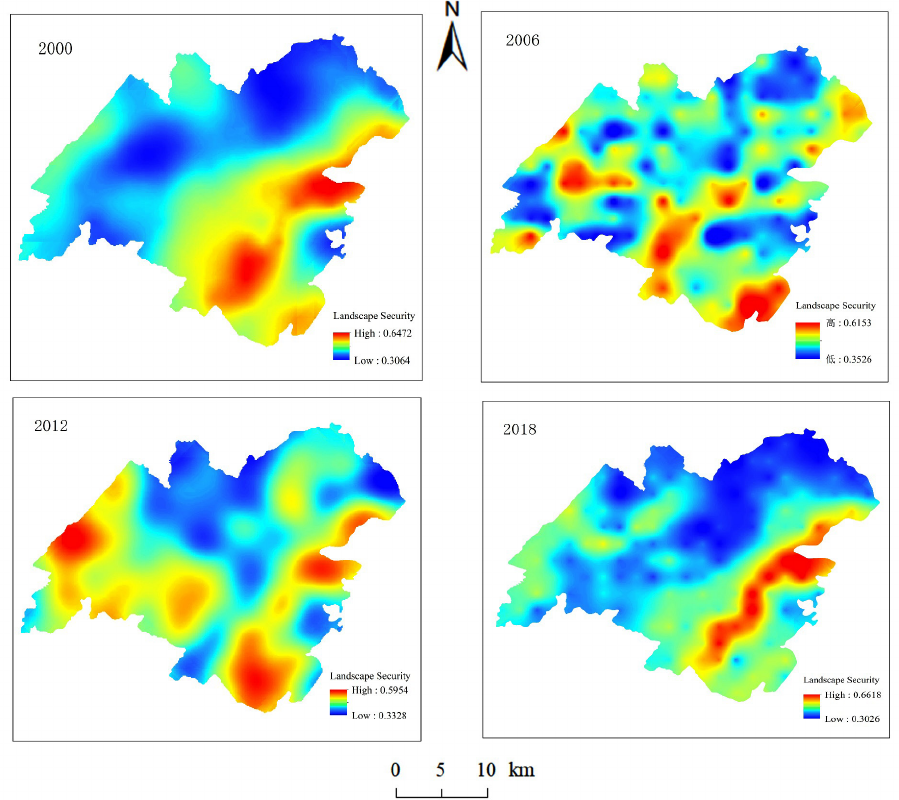
Figure 3. Spatial distribution of landscape ecological security in Zhong County from 2000 to